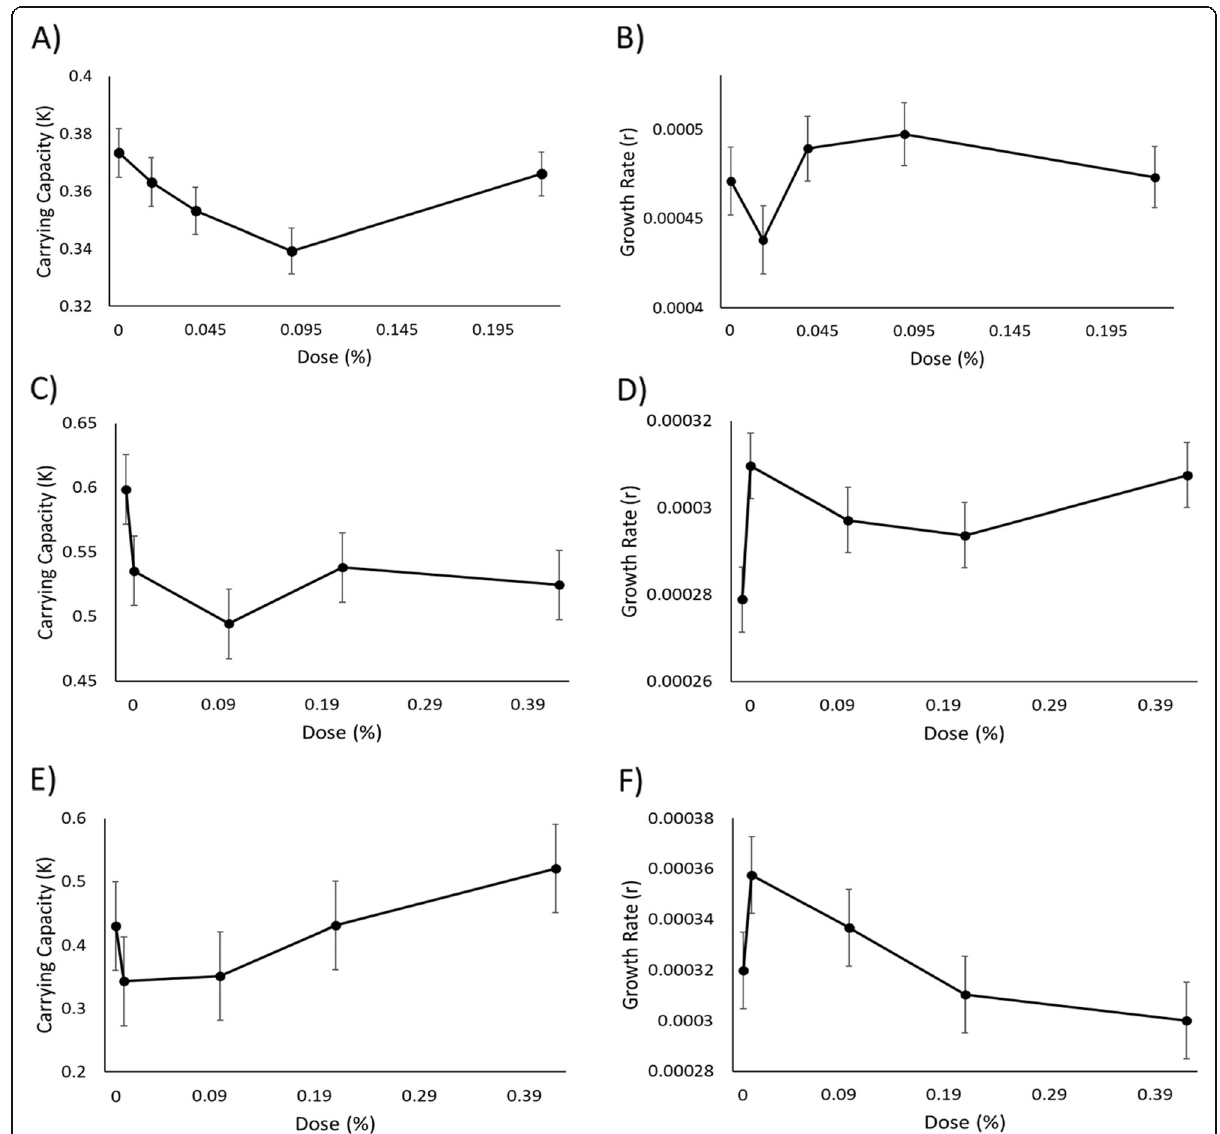
Fig. 1 Estimates of the population parameters of bacterial species display the carrying capacity (left) in response to microdoses for E. coli ( a ), S. aureus ( c ), and P. aeruginosa ( e ) and the intrinsic rate of growth (right) in response to microdose for E. coli ( b ), S. aureus ( d ), and P. aeruginosa ( f ). Doses correspond to the percentage of arborvitae solution as indicated in Additional file 3: Table S1. Error bars are ±1 p = 0.000931; Fig. 2d; Additional file 3: Table S2). The oil inhibited r of C. auris at low doses or at high doses, but not intermediate doses (Fig. 2d; Additional file 3: Table S2). Pairwise comparisons indicated a significant difference in r between 0.00 and 0.42%, 0.00 and 0.31%, and 0.00 and 0.10% (Additional file 3: Table S2).